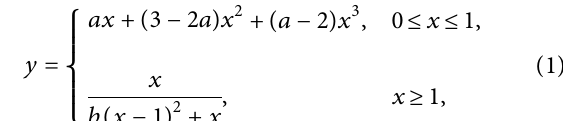
Figure 4: Loading device